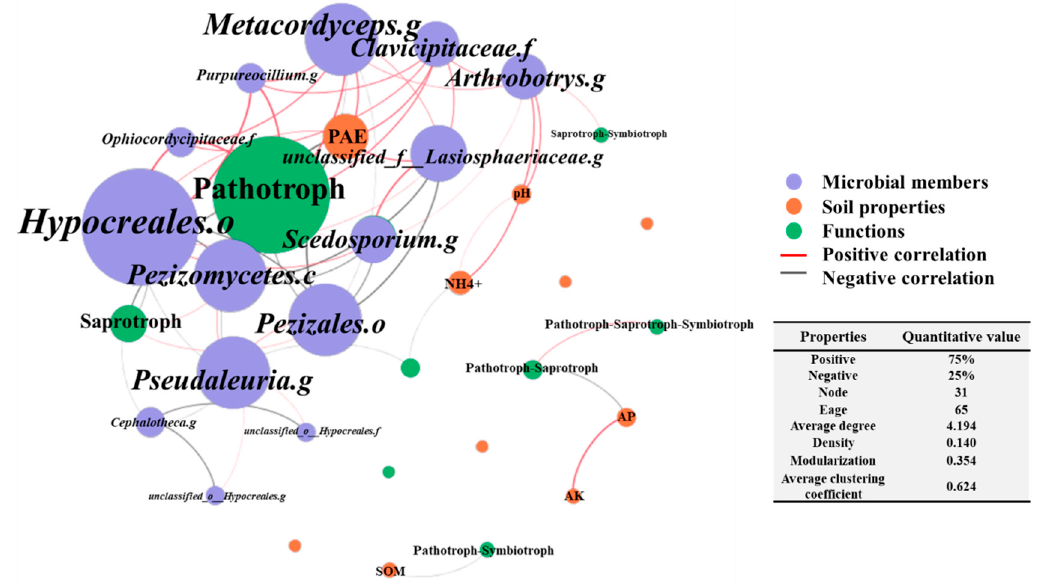
Figure 5. Co-occurrence network of the significantly different fungal members, predicted fungal functional roles and the soil physicochemical properties.